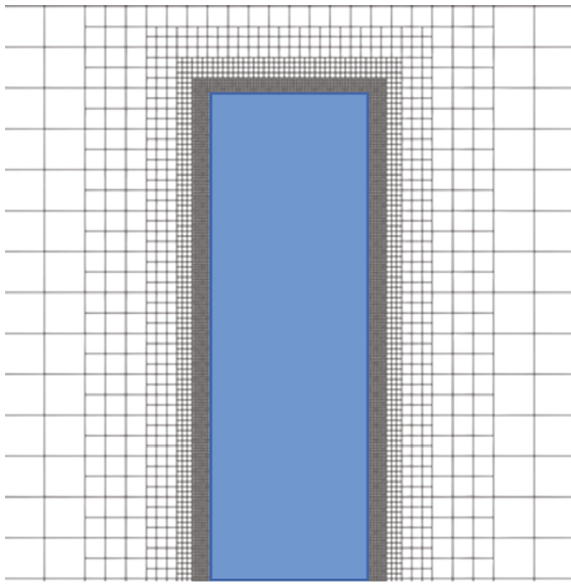
Figure 3: Grid division of the computing